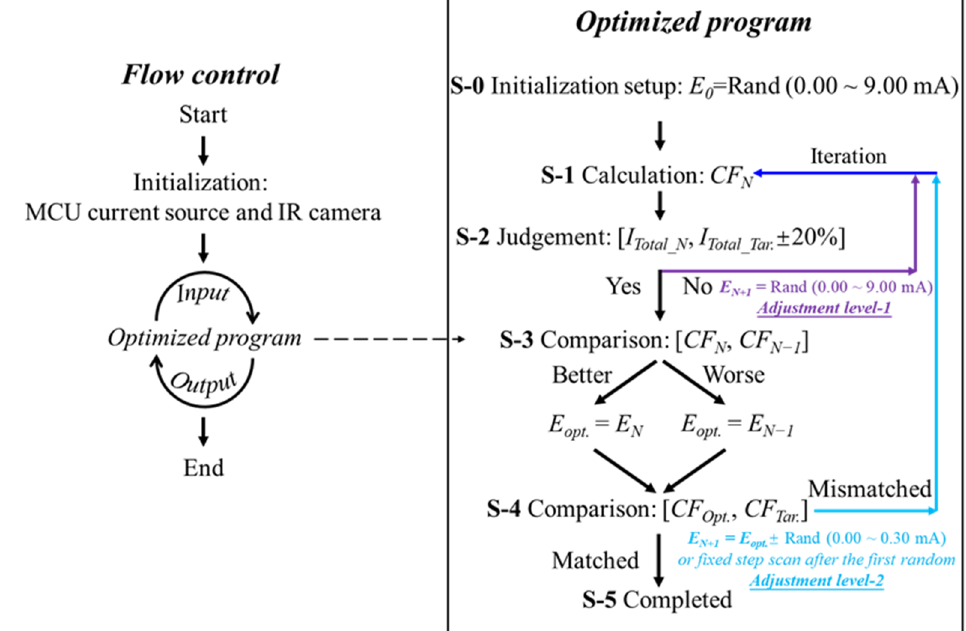
Figure 6. The diagram of the flow control and the multi-level search optimized program. CF , cost function; E , configuration of H 1 to H 4 ; Rand, random function; I Total , total output power of the three spots; Opt. , optimized; Tar. , targeted; N – 1 , last iteration; N , present iteration; N + 1 , next iteration.